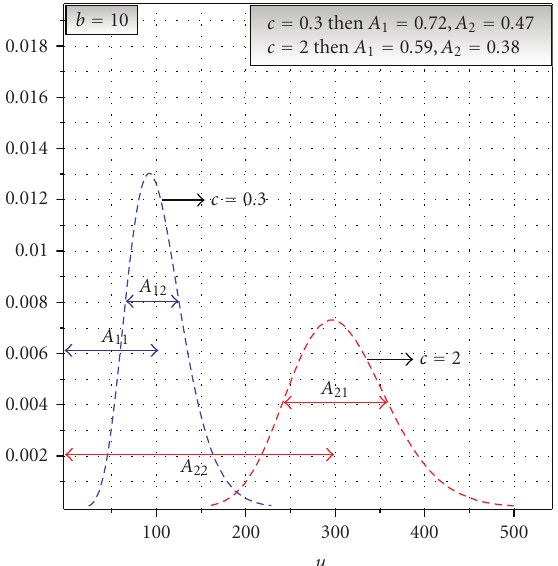
Figure 5: This plot illustrates how increasing c directly a ff ects A 1 and A 2 integrals and hence stretches its shape. Both PDFs plotted for constant b =